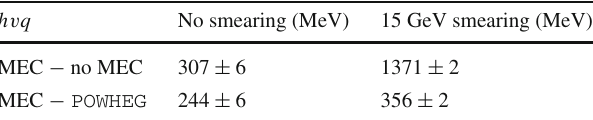
Table 11 Differences in the m Wb peak position for the h v q generator j showeredwith Herwig7.1 ,withMECswitchedoff(noMEC)orusing the Herwig7.1 POWHEG option, with respect to our default setting, that has MEC switched